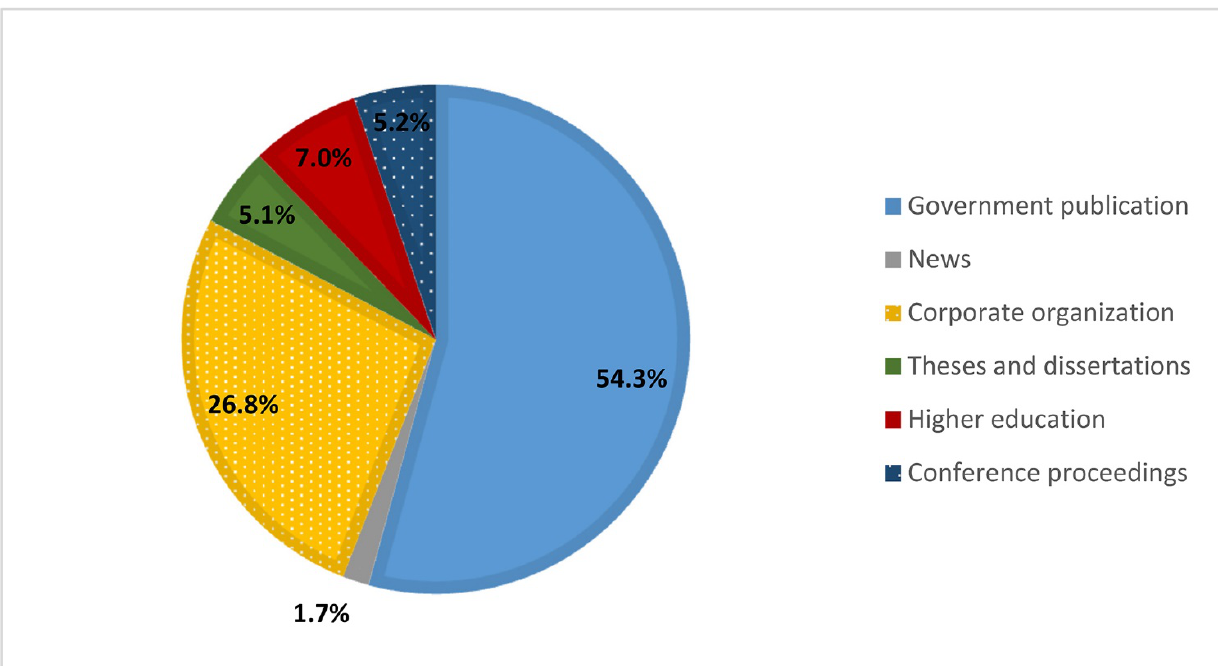
Figure 2 Percentage of grey literature types across